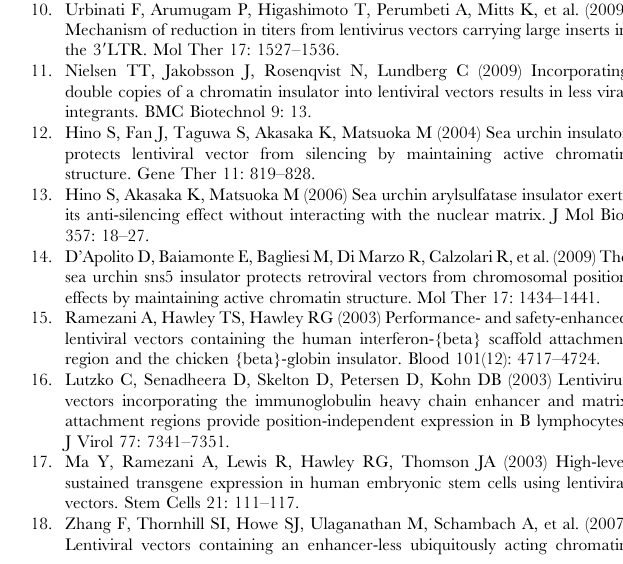
Table S1 VCN and number of integrants in primary trans- planted mice used as donors for CFU-S assays. The table shows the number of integration sites retrieved from BM of primary transplanted mice, the average vector copy number per BM cell, and the number of CFU-S analyzed for each primary transplanted mouse. Table S2 Human b -globin expression in mice transplanted with GLOBE- and G GLOBE-transduced BM. The table shows the percentage of human ß-globin positive RBC and the ratio between the areas of HPLC peaks corresponding to human ß and murine a globin chains in mice transplanted with GLOBE- and G GLOBE- transduced BM. Table S3 List of GLOBE proviral integration sites in secondary CFU-S. The table shows b -globin expression, chromosomal location of integrated provirus, target gene symbol, and RefSeq identifier number in secondary CFU-S. Integrations were annotated as inside or outside (intergenic) known genes (University of California at Santa Cruz annotation). Table S4 List of G-GLOBE proviral integration sites in secondary CFU-S. The table shows b -globin expression, chromo- somal location of integrated provirus, target gene symbol, and RefSeq identifier number in secondary CFU-S. Integrations were annotated as inside or outside (intergenic) known genes (University of California at Santa Cruz